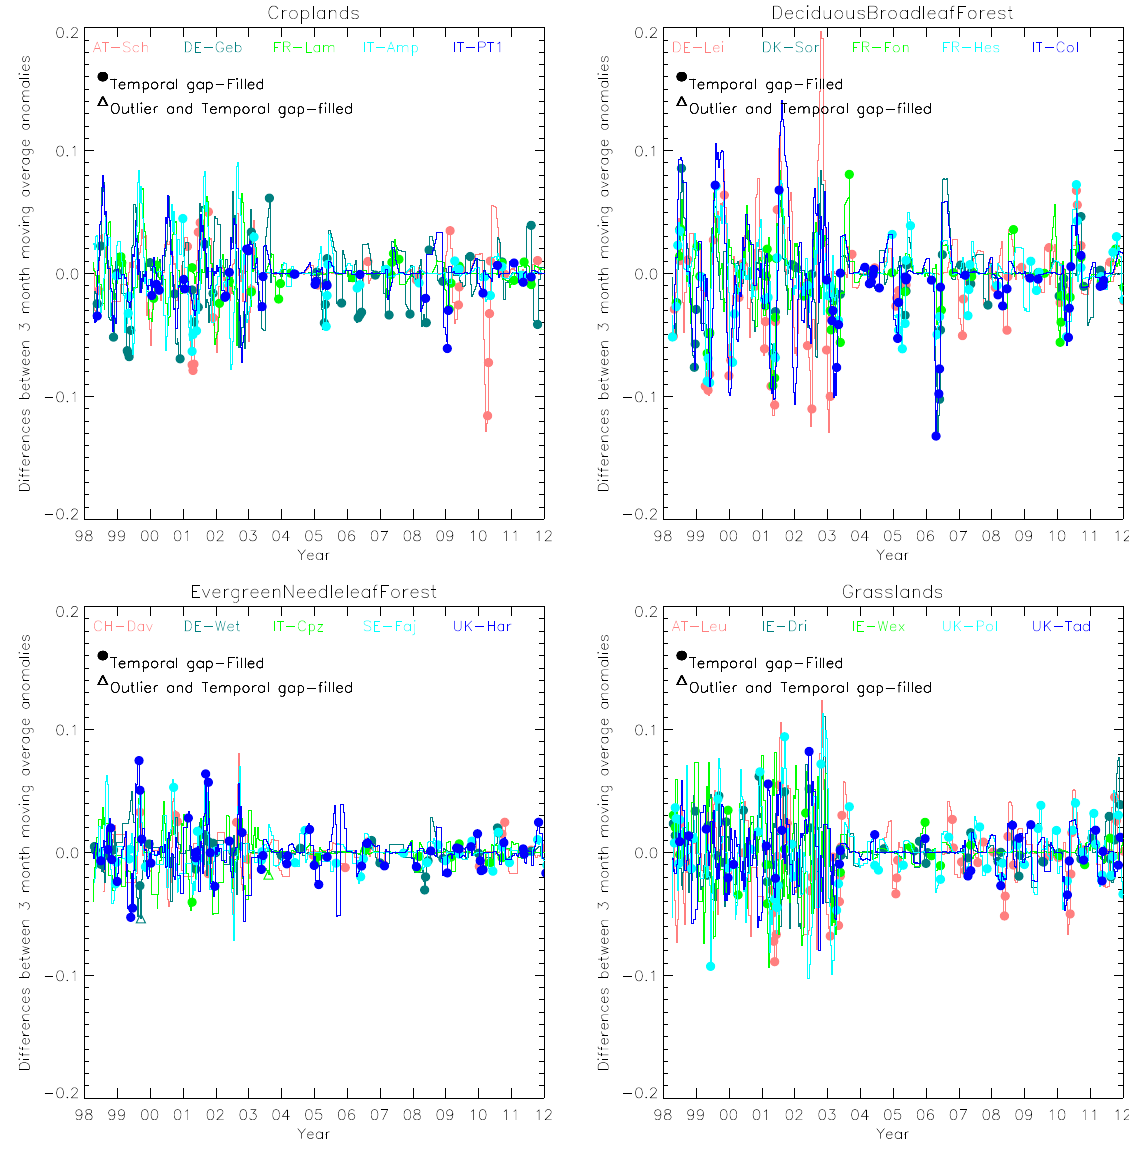
Figure 10. Differences between three-month moving average anomalies over local sites with different land use using the original and the harmonized